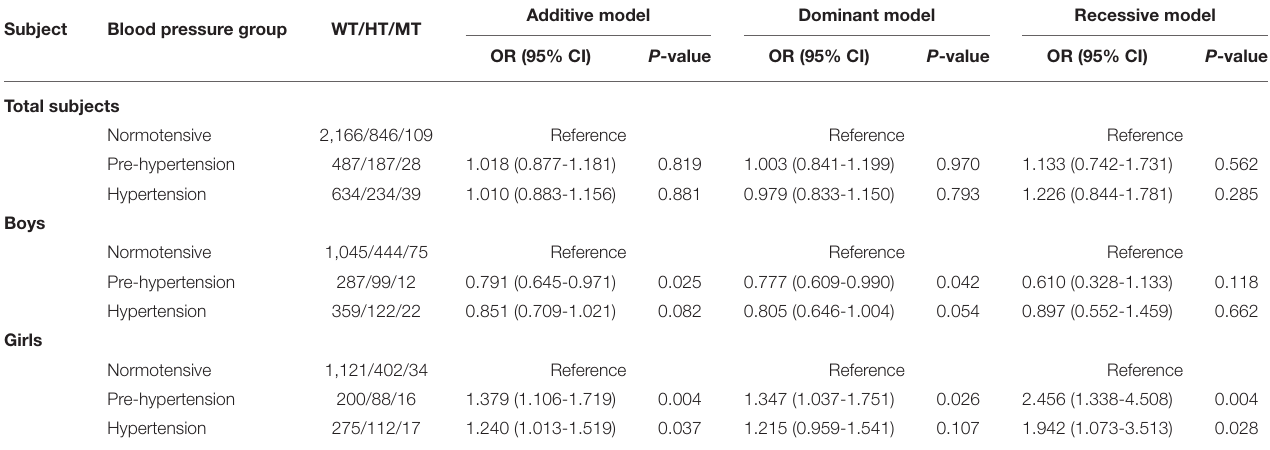
TABLE 4 | Association analysis of GHR fl/d3 polymorphism with pre-hypertension and hypertension.